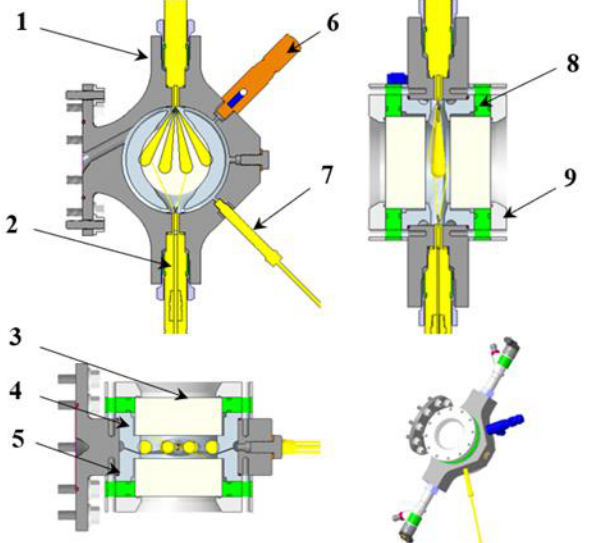
Figure 10. OPOC optical combustion chamber: 1 — Steel frame; 2 — Injector; 3 — Quartz glass; 4 — Exhaust piston cap; 5 — Intake piston cap; 6 — Safety valve; 7 — Dynamic pressure sensor; 8 — Sealing plate; 9 — Closing cap.